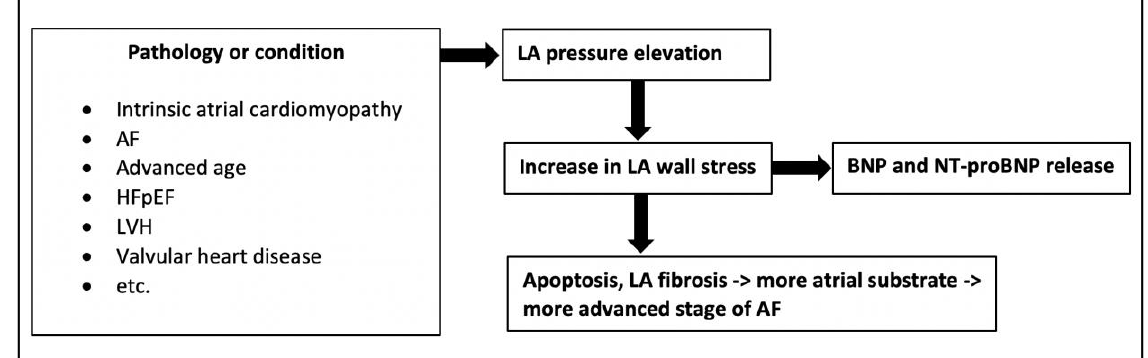
Figure 4. Pathophysiology of NT-pro-BNP serum levels and left atrial pressure. Association between mean LAP, pre-procedural NT-pro-BNP levels and AF disease progression [24 – 26]. AF = atrial fibrillation, HFpEF = heart failure with preserved ejection fraction, LVH = left ventricular hypertrophy, LA = left atrial, BNP = brain-type natriuretic peptide.